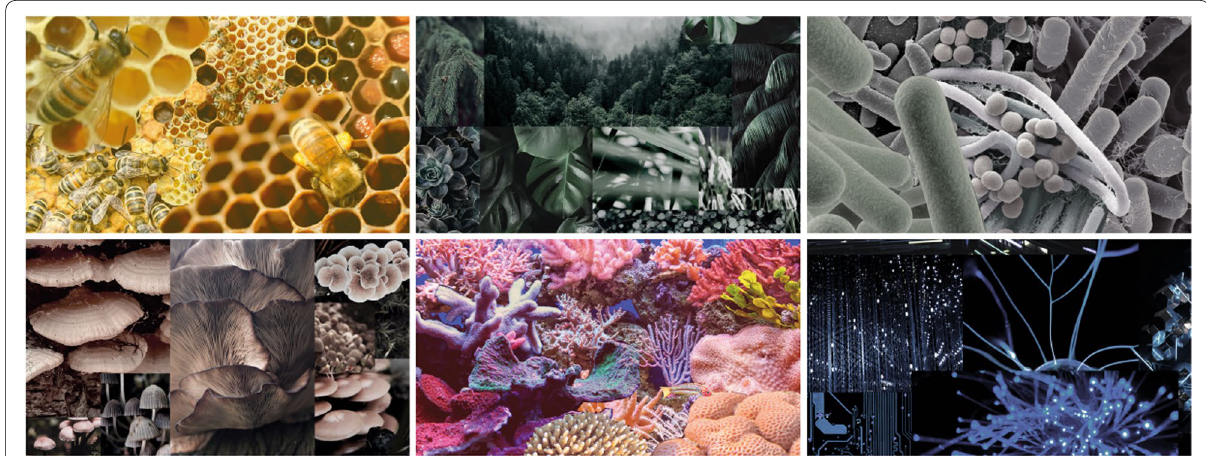
Fig. 2 Visual elements of the provotype of the 1 st Multispecies Symposium for the simulation of the species representatives (from left to right: bees, mushrooms, plants, corals, bacteria) and the technical supporter of interspecies communication (bottom right: Artificial Intelligence). Each frame simulates the visualization via interface of the species taking the floor during the